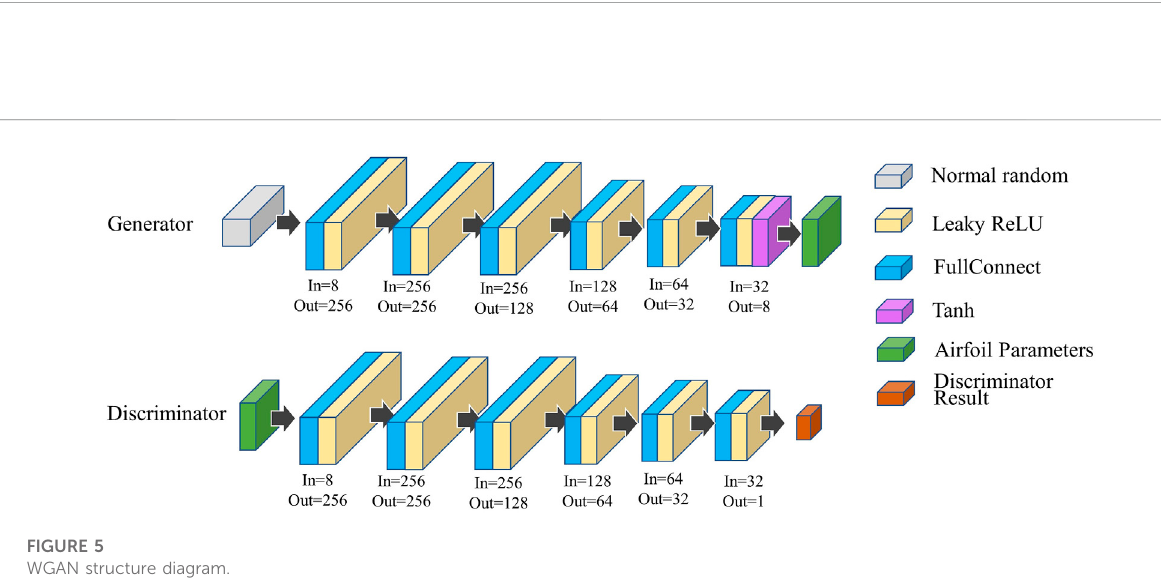
FIGURE 5 WGAN structure diagram.